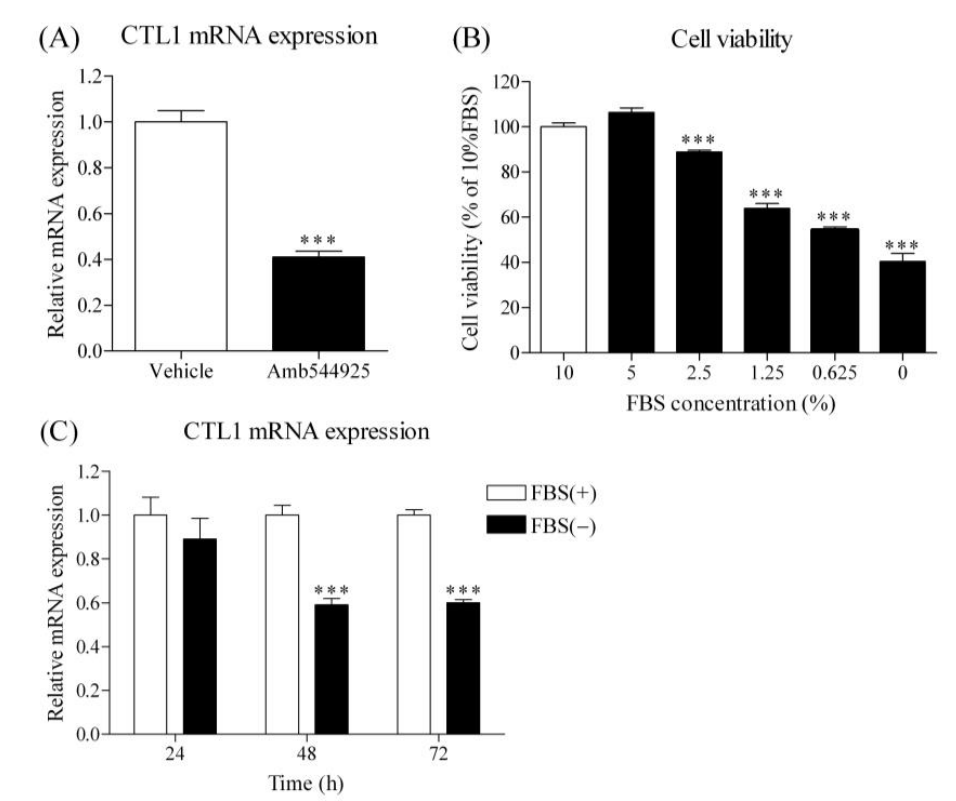
Figure 8. Effect of Amb544925 and FBS on CTL1 mRNA expression in HSC-3 cells. ( A ) Cells were incubated with 10 µ M Amb544925 for 24 h, and then CTL1 mRNA expression was measured by real-time PCR ( n = 4). The expression level of CTL1 mRNA was expressed as the ratio of the expression level of Amb544925 treatment to that of the vehicle control. *** p < 0.005 compared to the vehicle control. Effect of FBS on cell viability ( B ) and CTL1 mRNA expression ( C ) in HSC-3 cells ( n = 4). The cell viability of HSC-3 cells cultured in medium containing various concentrations of FBS for 48 h was measured. Results are given as a percentage of cell viability measured in the presence of 10% FBS. *** p <0.005 compared to 10% FBS. ( C ) Effect of FBS on CTL1 mRNA expression in HSC-3 cells ( n = 4). Cells were cultured in the presence (FBS+) and absence (FBS − ) of 10% FBS for 24, 48, and 72 h, and then CTL1 mRNA expression was analyzed by real-time PCR. *** p < 0.005 compared to 10% FBS